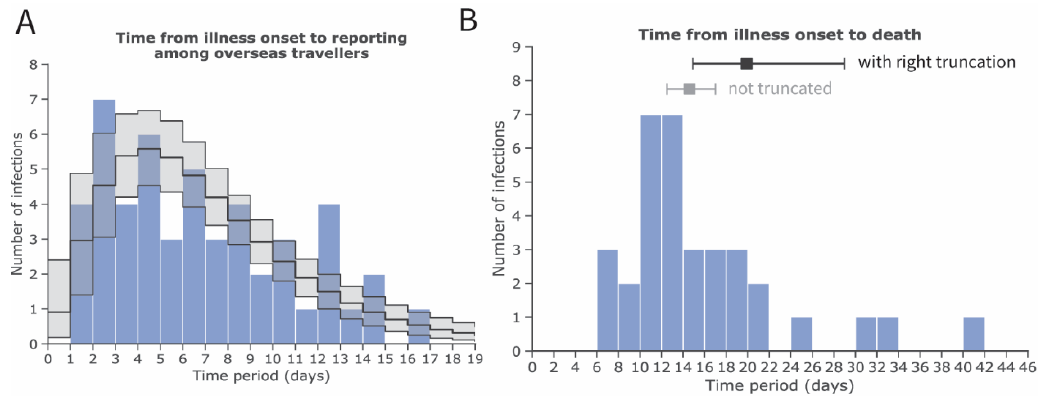
Figure 1. Estimates of the mean and standard deviation (SD) of the time from illness onset to reporting and death cases, accounting for right truncation, with novel coronavirus (COVID-19) infection in China, 2020. Inference of A and B was conducted among ( A ) exported cases observed in other countries and ( B ) deceased cases in China. ( A ) Frequency distribution of the time from illness onset to reporting among exported cases employing a gamma distribution with a mean of 7.1 days (95% confidence interval [CI]: 5.9, 8.4) and SD of 4.4 days (95% CI: 3.5, 5.7). ( B ) Frequency distribution of the time from illness onset to death with a mean of 19.9 days (95% CI: 14.9, 29.0) (shown in black) and SD of 11.4 days (95% CI: 6.5, 21.6) employing a lognormal distribution and accounting for right truncation. For reference, the estimate of the mean and its 95% credible intervals without accounting for right truncation are shown in grey. The values for distribution of time from illness onset to death are adopted from an earlier study [14]. The blue bars show empirically observed data collected from governmental reports (as of 24 January